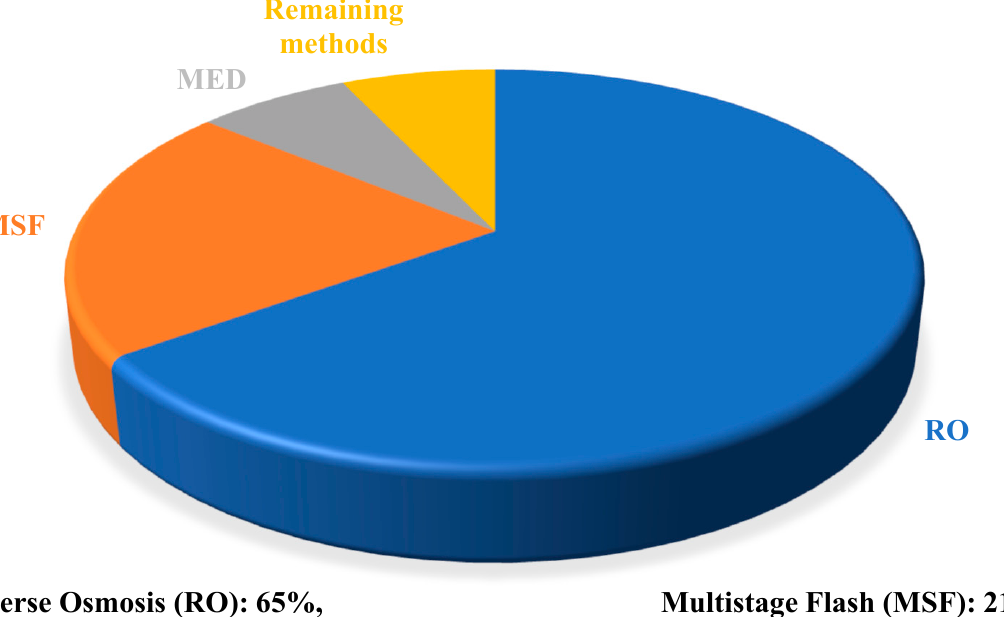
Figure 1. Shares of thermal and membrane water desalination technologies (Adapted from [15]).